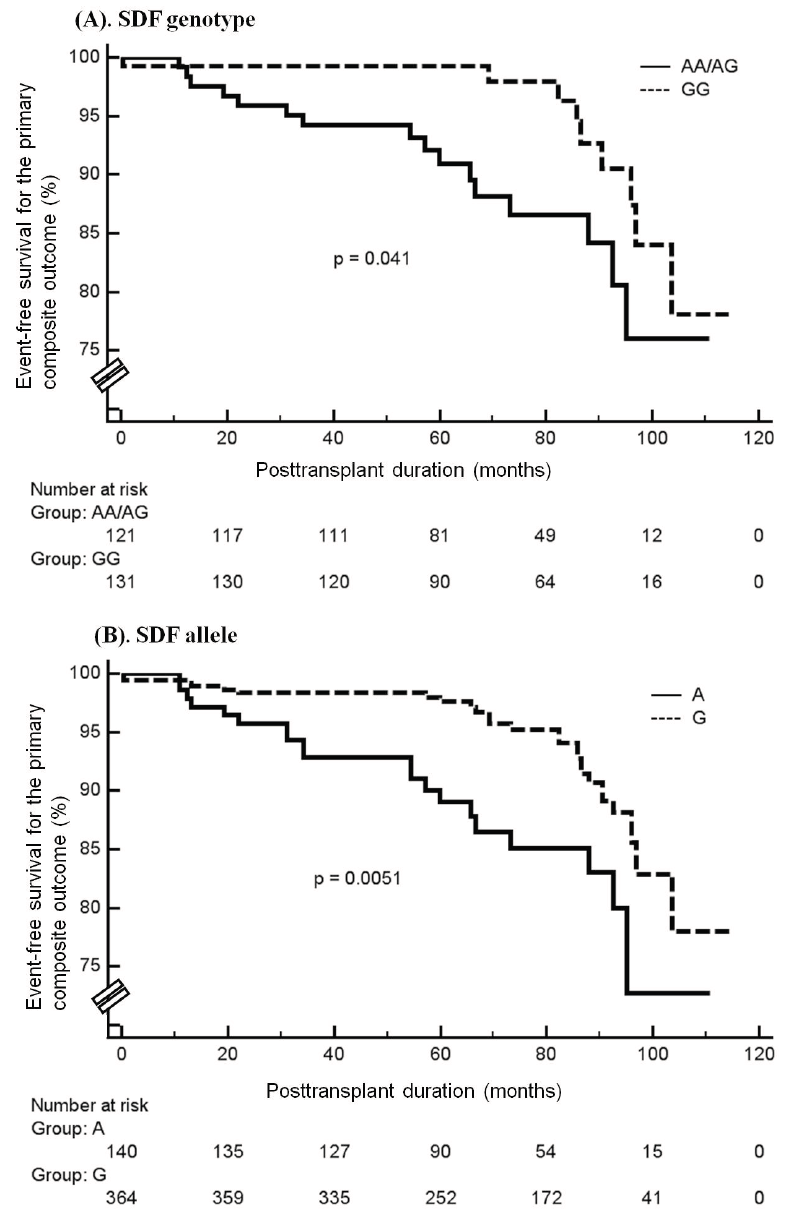
Figure 2. Kaplan-Meier curve and log-rank test comparing the cumulative event-free probability of time to an adverse outcome between patients with SDF-1 genotype AA/AG or GG ( A ) and those with the SDF-1 allele A or G ( B